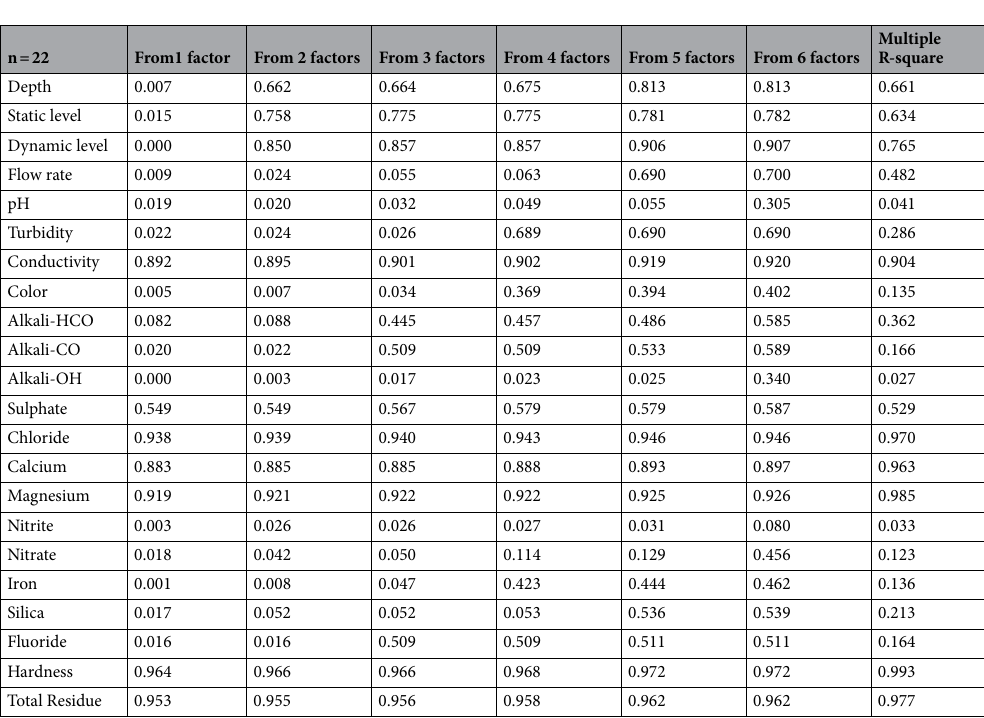
Table 6. Communalities (Data Bank with 600 wells). Extraction: Principal Component Analysis. Rotation: Varimax Normalized.